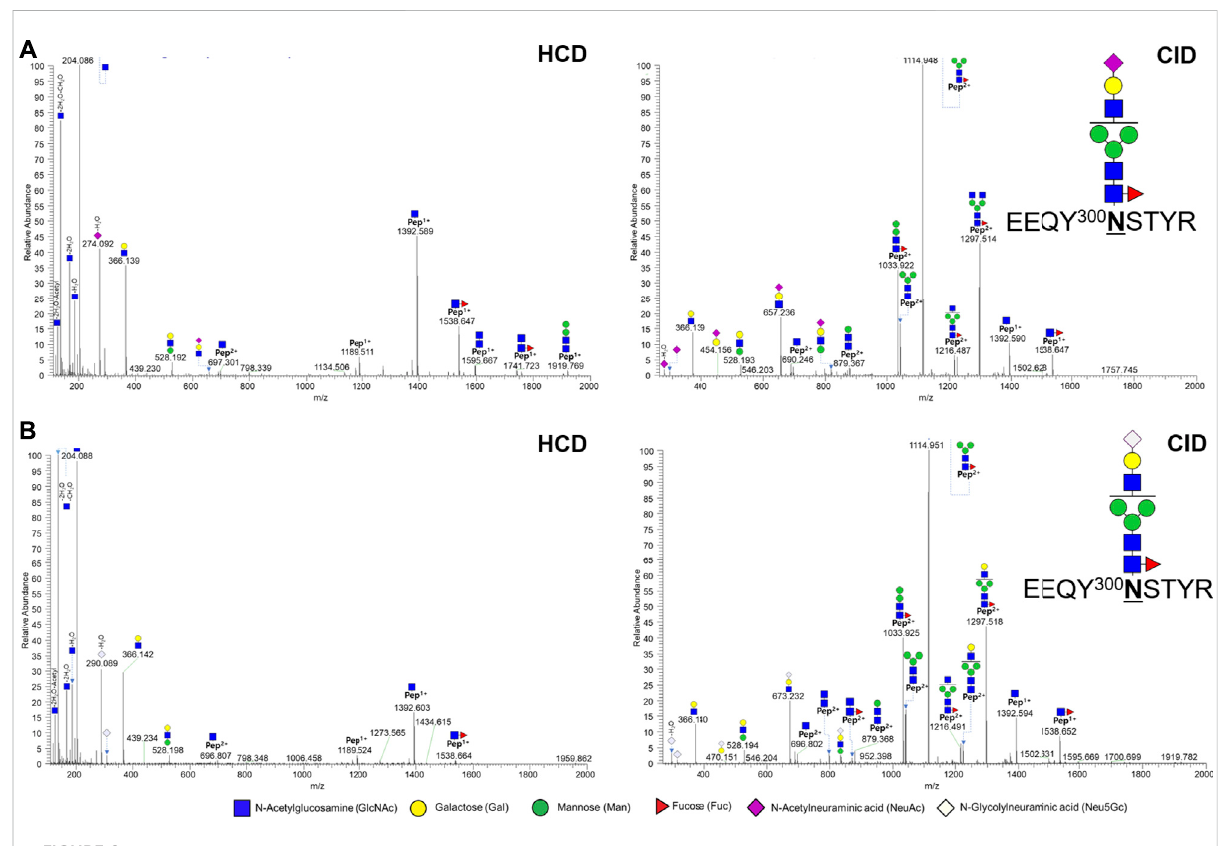
FIGURE 2 Representative tandem spectra of N-glycopeptides with NeuAc and N-glycopeptides with NeuGc from the Fc region in In fl iximab. (A) EEQY 300 N STYR_4_3_1_1_0 (m/z 962.38, 3+) and (B) EEQY 300 N STYR_4_3_1_0_1 (m/z 967.71,